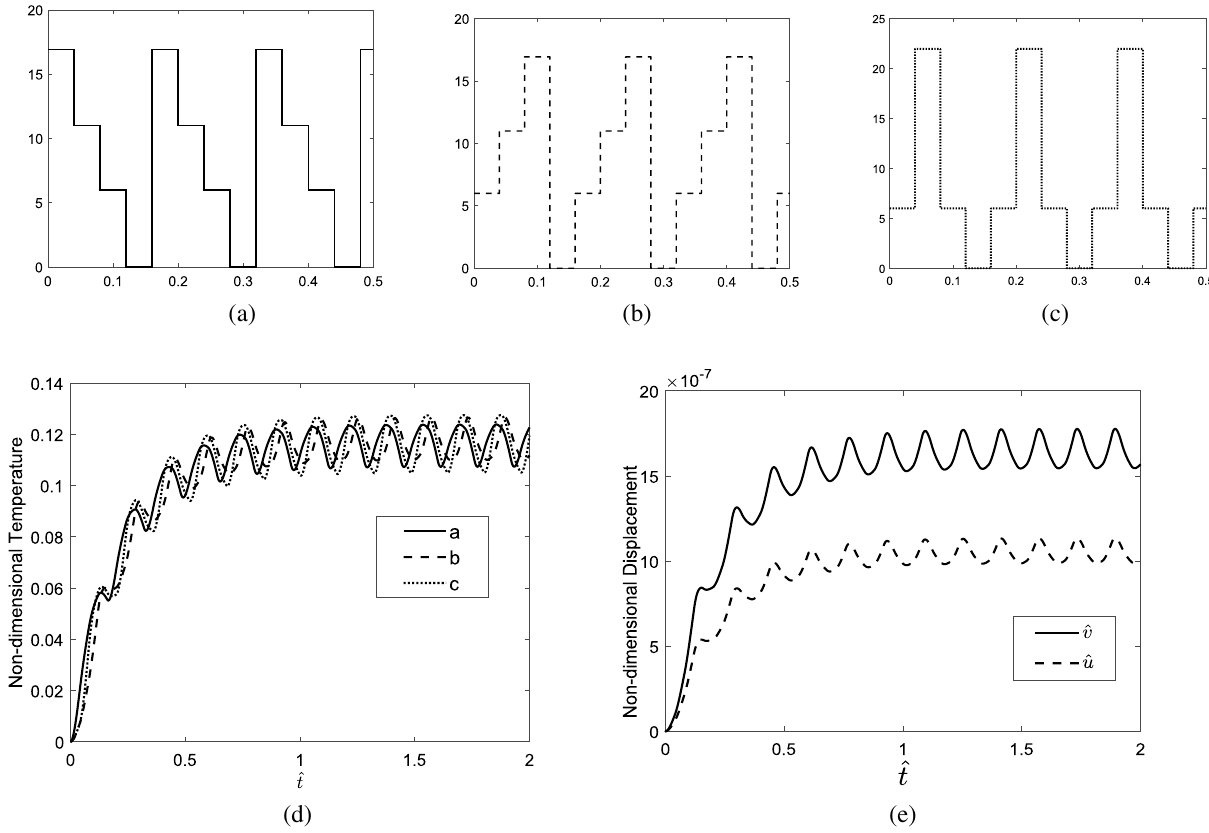
Figure 8. ( a – c ) Different types of repeating sequence stairs, ( d ) non-dimensional temperature of tissue considering different types of repeating sequence stairs heating sources, ( e ) time-domain displacement response of tissue in radial and depth